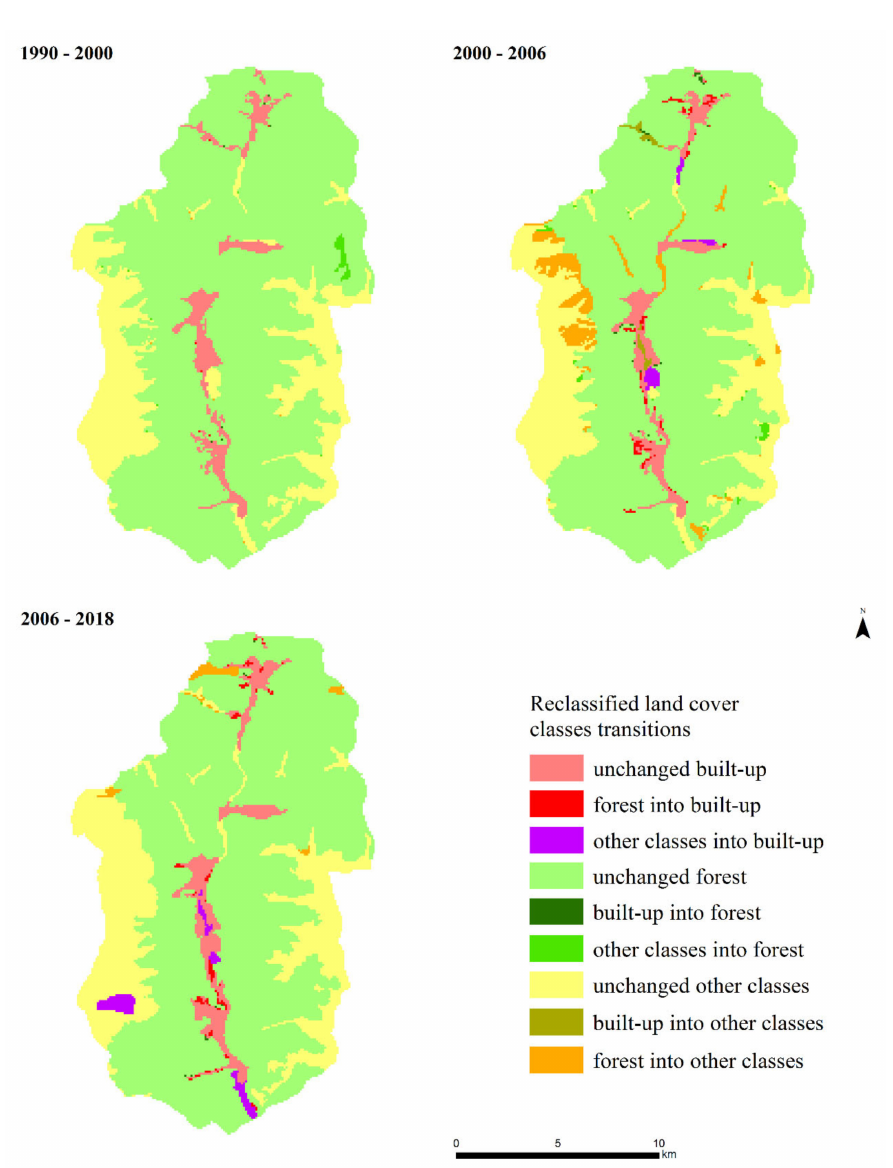
Figure 4. Reclassified land cover classes transition map based on a Markov chains model developed over 3 time periods (1990–2000, 2000–2006, 2006–2018). Finally, we identified several hotspots where households frequently involved in HWI (after 1990) were developed on areas previously occupied by forests (before 1990) (Figure